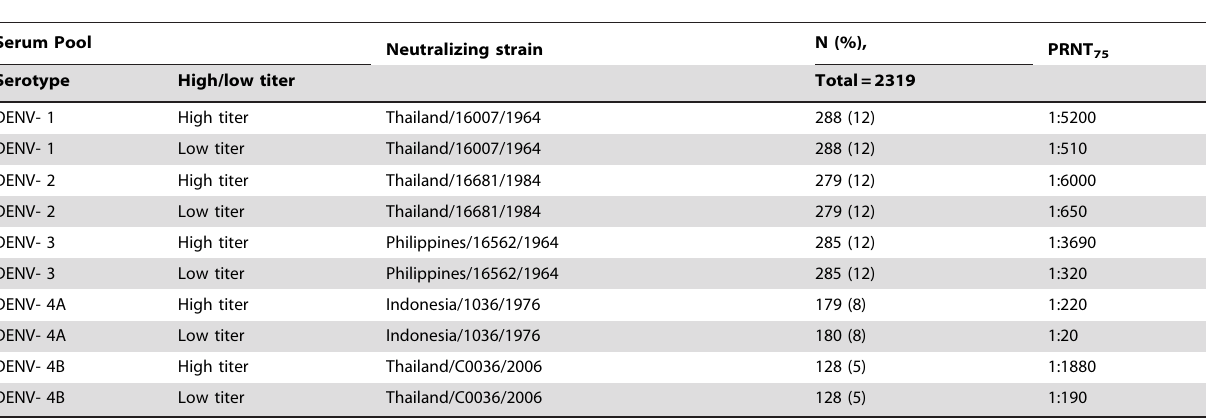
Table 1. Number of experiments by serum pool and viral strain combination.